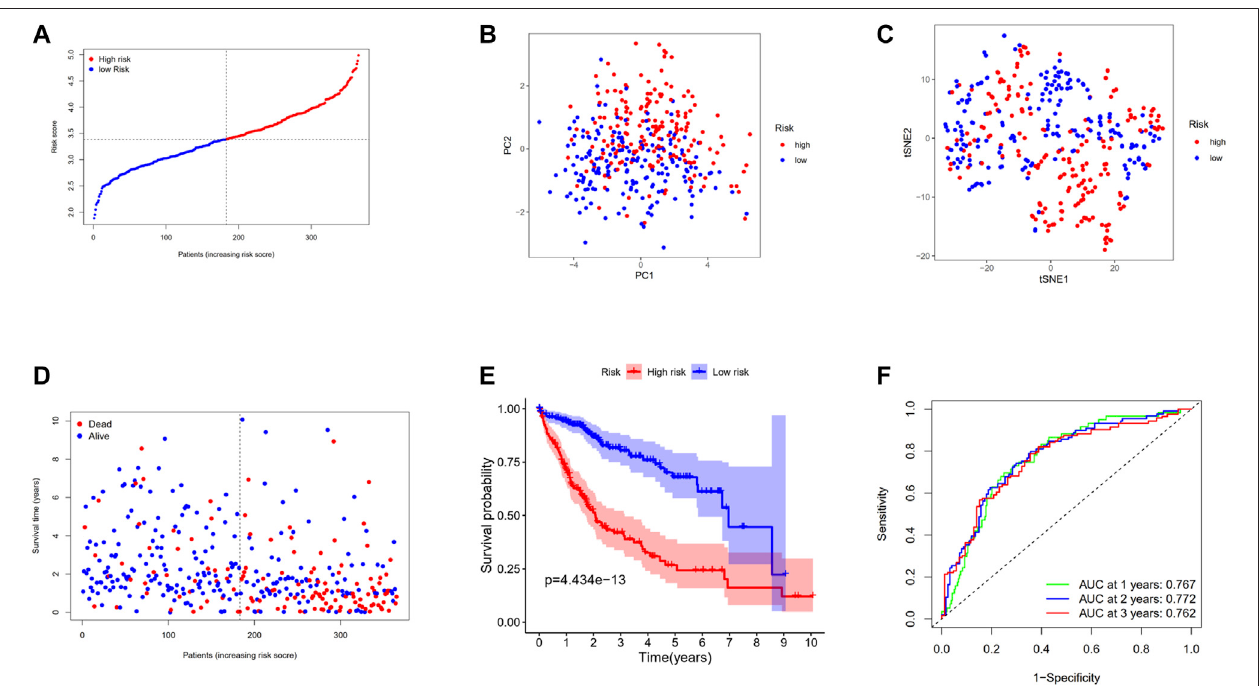
FIGURE6| Prognosticanalysisofthe12-genesignaturemodelintheTCGAcohort. (A) ThedistributionandmedianvalueoftheriskscoresintheTCGAcohort. (B) PCAplotoftheTCGAcohort. (C) t-SNEanalysisoftheTCGAcohort. (D) ThedistributionsofOSstatus,OS,andriskscoreintheTCGAcohort. (E) Kaplan – Meiercurves for the OS of patients in the high-risk group and low-risk group in the TCGA cohort. (F) AUC of time-dependent ROC curves veri fi ed the prognostic performance of the risk score in the TCGA cohort.